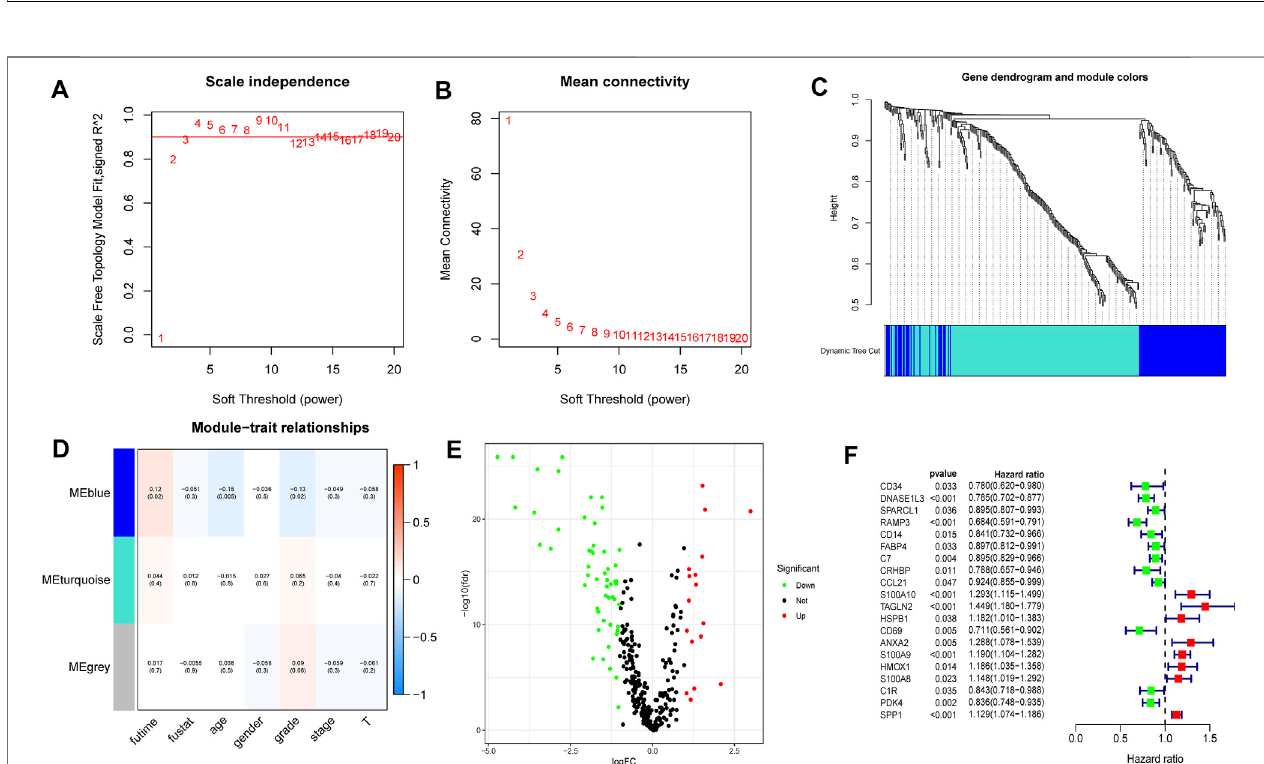
FIGURE7| WGCNAanalysis,differentialexpressionanalysisandunivariateanalysisofDRGs (A – C) .BasedonWGCNA,threemoduleswereobtainedusingasoft power of 3 (D) . The blue module closely correlated HCC grade (E) . 72 differentially expressed DRGs were identi fi ed (F) . Univariate analysis identi fi ed 20 prognosis- related DRGs.